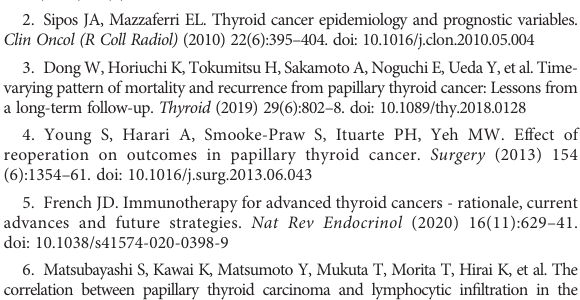
CD25 + CD4 + T cells. Tissue CD8 + T cells were further divided into eight subsets by PD-1, CD39 and CD103. SUPPLEMENTARY FIGURE 2 Feature plots of t-SNE maps and comparison of CD8 + T, CD4 + T, B cells and monocytes in peripheral blood and thyroid tissues from MNG patients. (A) Feature plots of CD3, CD4, CD8, CD56, CD19, and CD14 expression. Frequencies (B) and density (C) of CD4 + T (CD4 + CD45 + ), CD8 + T (CD8 + CD45 + ), NK (CD56 + CD45 + ) and B (CD20 + CD45 + ) cells in CD45 + cells in MNG tissues by mIHC. Percentages of B cells (D) and monocytes (E) in MNCs in peripheral blood and thyroid tissue by fl ow cytometry. Percentages of CD8 + T (F) and CD4 + T (G) cells in T cells (CD3 + CD56 - ) in peripheral blood and thyroid tissue by fl ow cytometry. Data presented as mean ± SEM. * p < 0.05; ** p < 0.01; *** p < 0.001. SUPPLEMENTARY FIGURE 3 Composition of immune cell subsets in MNG and PTC patients. (A) Percentages of CD8 + T, CD4 + T, CD3 + CD56 + , NK, B cells and monocytes in MNCs in MNG, paratumor, tumor tissue. (B) Percentages of CD8 + T, CD4 + T, CD3 + CD56 + , NK, B cells and monocytes in PBMC from MNG and PTC patients. SUPPLEMENTARY FIGURE 4 Treg cell subsets in MNG and PTC patients. The ssGSEA score of CD45RA + FoxP3 lo CD25 ++ cells (A) , CD45RA - FoxP3 hi CD25 +++ cells (B) , and CD45RA - FoxP3 lo CD25 ++ (C) in MNG, paratumor and tumor tissues. SUPPLEMENTARY FIGURE 5 mIHC-based quanti fi cation of immune cell subsets in tissues from MNG and PTC patients and clinical signi fi cance of PTC-in fi ltrating CD8 hi T cell subsets based on the expression of PD-1 and CD39. Frequencies and density of PD-1 + CD39 + CD8 + T (A) , PD-1 + CD39 - CD103 - CD8 + T (B) , PD- 1 + CD39 - CD103 + CD8 + T (C) , PD-1 - CD39 + CD103 - CD8 + T (D) , PD-1 - CD39 + CD103 + CD8 + T (E) , PD-1 - CD39 - CD103 - CD8 + T (F) and PD-1 - CD39 - CD103 + CD8 + T (G) cells in non-recurrent PTC tissues (n=23) and recurrent PTC tissues (n=8) by mIHC. (H) Comparison of pathological subtypes, gender and the recurrence free survival among 4 clusters in TCGA database, including PD-1 hi CD39 hi (n=46), PD-1 lo CD39 lo (n=47), PD-1 lo CD39 hi (n=51), PD-1 hi CD39 lo (n=51) clusters. SUPPLEMENTARY FIGURE 6 Enrichment scores of neutrophils, NK cells and Th17 cells in CD8 hi T cell subsets. GSVA enrichment scores of the classical gene signatures for neutrophils (A) , NK cells (B) and Th17 cells (C) among PD- 1 hi CD39 lo CD103 hi , PD-1 hi CD39 hi CD103 lo , PD-1 lo CD39 hi CD103 hi clusters and other 5